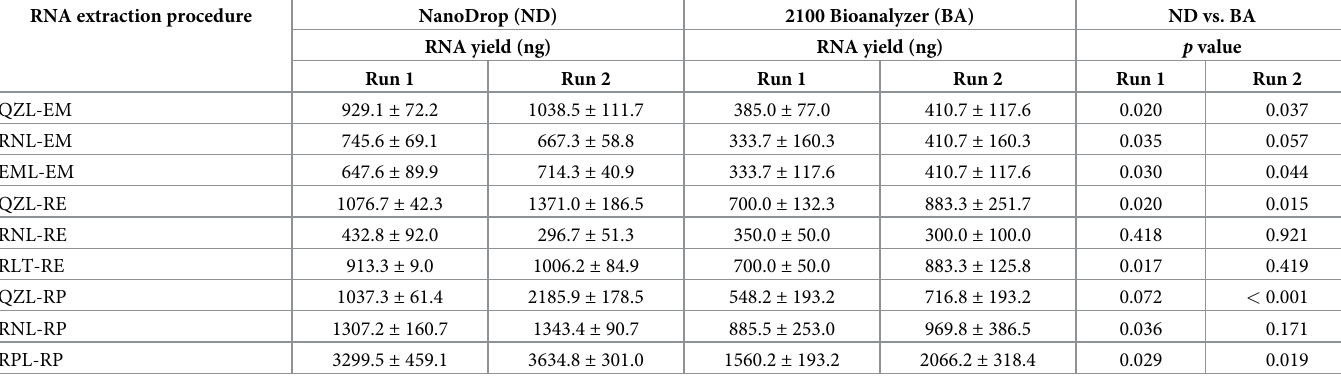
Results are means and standards deviation (in ng) from three independent extractions.